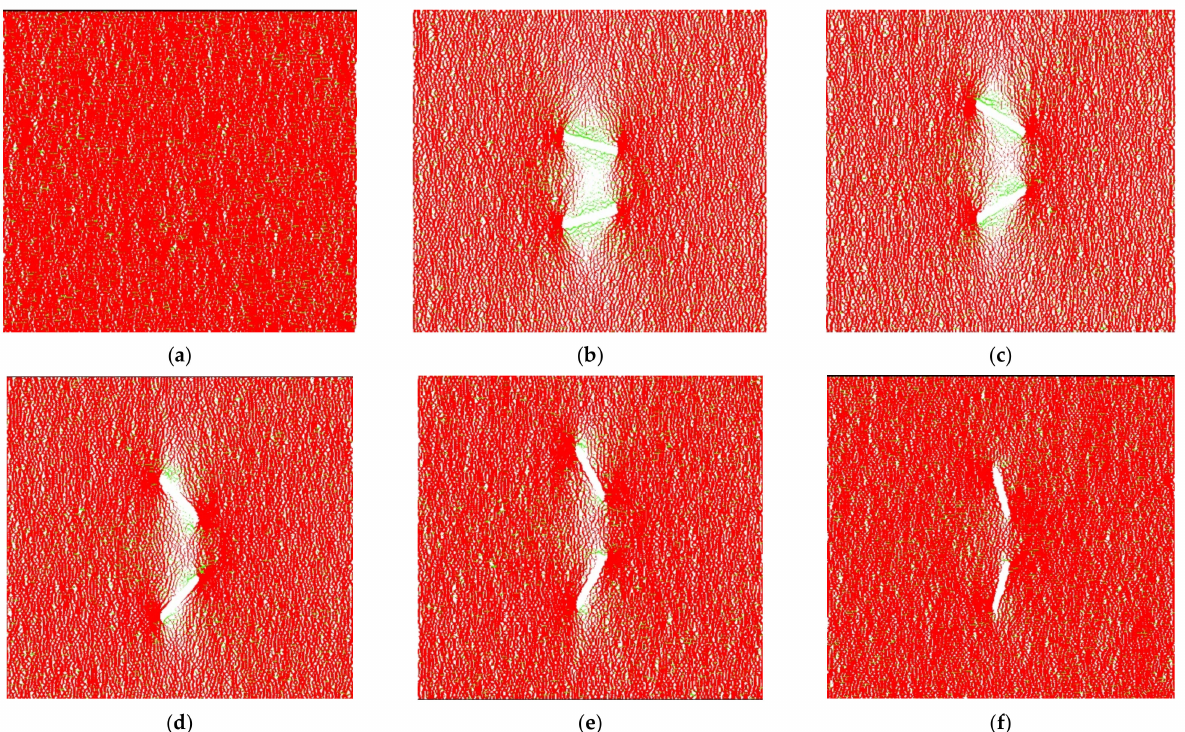
Figure 10. Parallel bond force distribution of different models just before crack initiation stress.